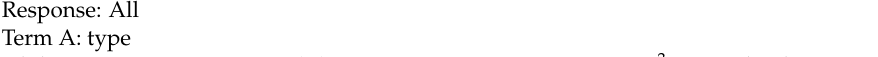
Table 10. Bonferroni (All-Pairwise) Multiple Comparison